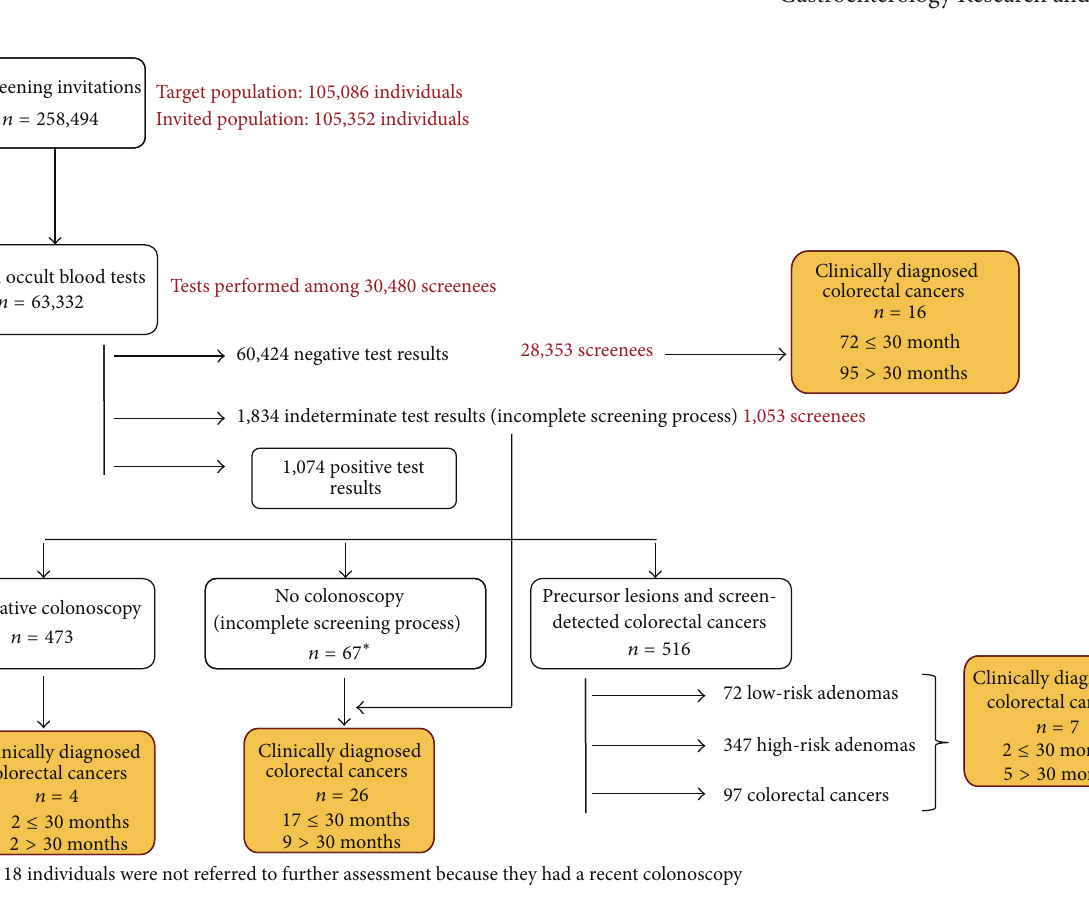
Figure 1: Flowchart of the screening process from 2000 to 2010. Table 2: Clinically diagnosed CRC among screening participants according to the test used (gFOBT or FIT) and their last screening